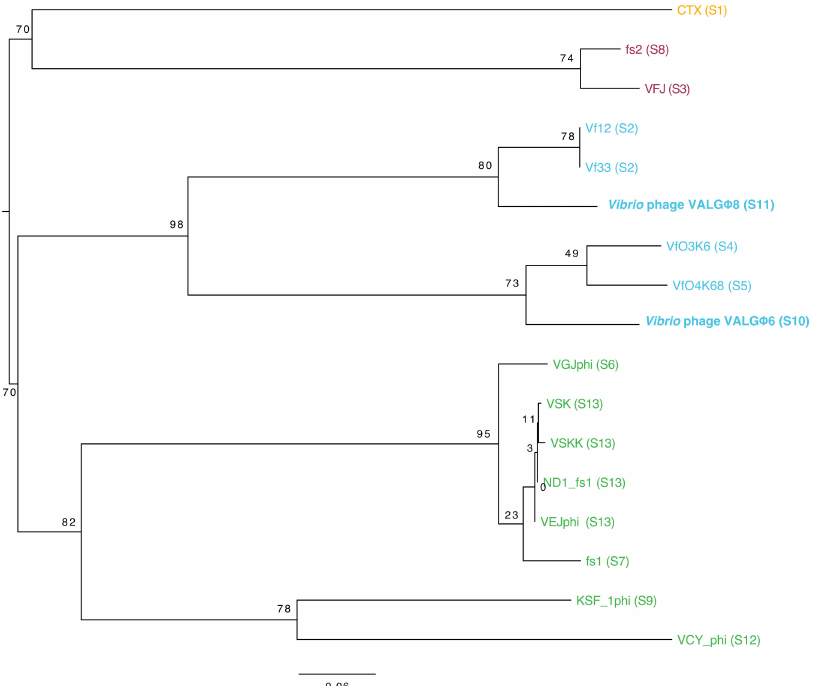
Figure 5. Mid-rooted phylogenomic GBDP tree inferred from VICTOR using the formula D0. The numbers above branches are GBDP pseudo-bootstrap support values from 100 replications. The OPTSIL clustering yielded twelve species clusters, four genus clusters and one cluster at the family level. Filamentous phages belonging to the same genus are color-coded. Same species are indicated by S1–S13 in brackets behind each phage name. Both filamentous phages, sequenced in the present study are highlighted with bold letters. Accession numbers of all filamentous phages can be found in Table